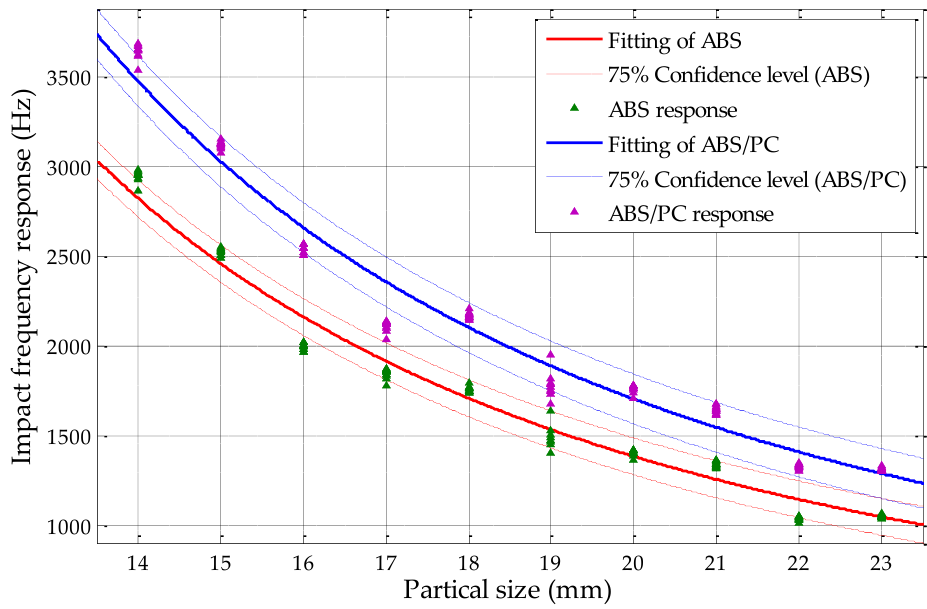
Figure 19. Confidence intervals of ABS and ABS/PC at the 75% confidence level by using fine sieving diameter determination.